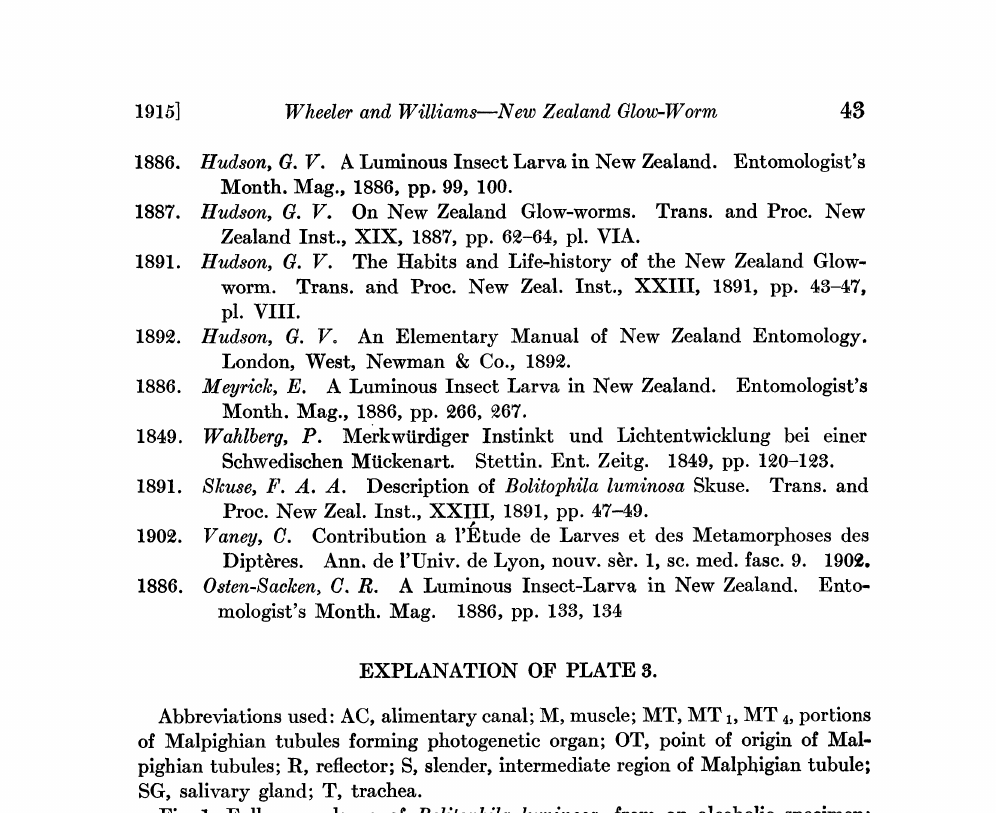
. Fig. 1. Full-grown larva of Bolitophila luminosa, from an alcoholic specimen; lateral view. Caudal third of body of larva, showing alimentary canal and Malpighian Fig. tubules; ventral view. Fig. 3. Distal portion of Malpighian tubules modified to form photogenetic organ; ventral view. , Fig. 4. Cross-sections through Malpighian tubules; the smaller, upper section the larger, lower one from a region much further forward. from the region S, Fig. Fig. 5. Section of a piece of the fat-body from the last abdominal segment. Fig. 6. Cross-section through tips of photogenetic portions of two of the MaN pighian, tubules. Fig. 7. Cross-section through the middle of all four of the Malpighian tubules in the photogenetic region. The reflecting layer R is